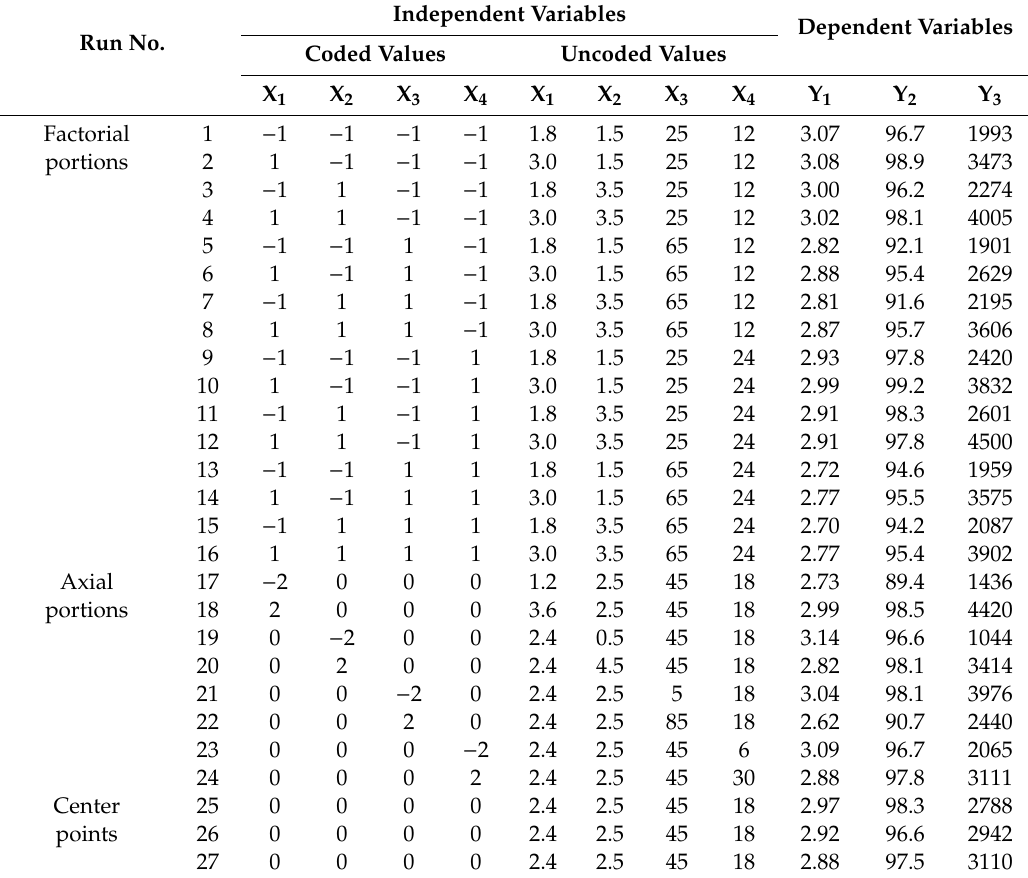
Table 2. The CCD matrix and experimental values of the dependent variables for each independent variable.